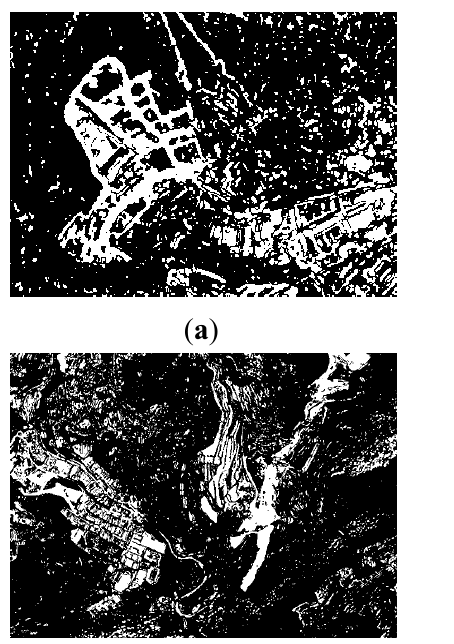
= 0.6, λ = 0.4) ( a ) Summative CVA NDVI